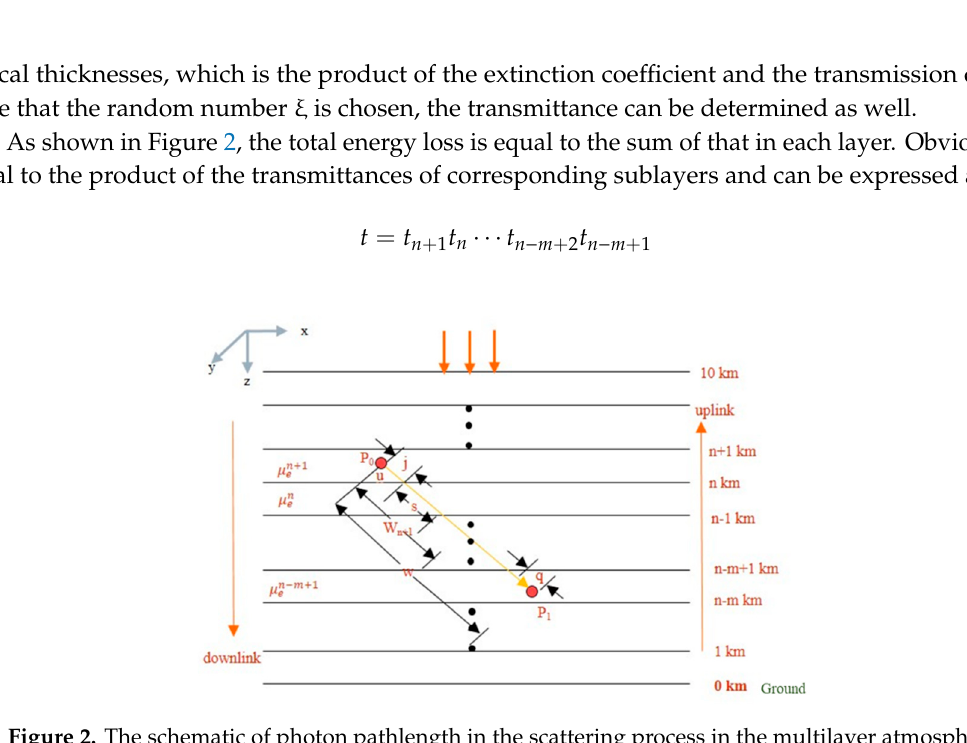
Figure 2. The schematic of photon pathlength in the scattering process in the multilayer atmosphere.